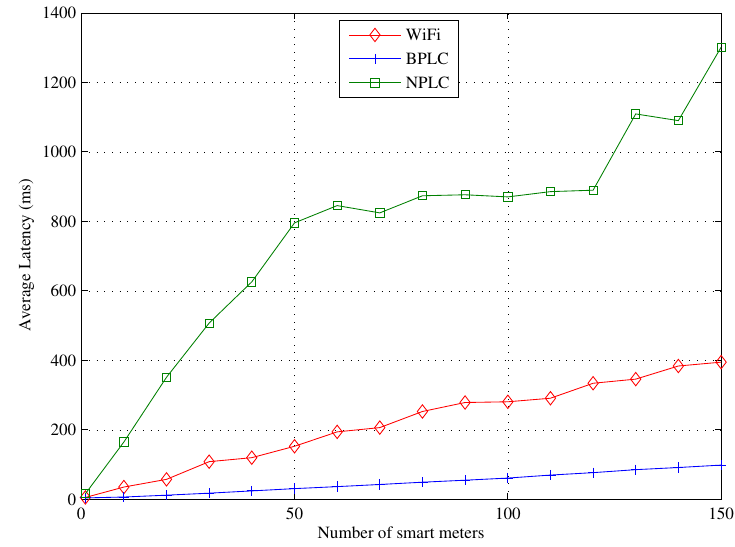
Figure 7. Smart metering round-trip latency versus number of smart meters.